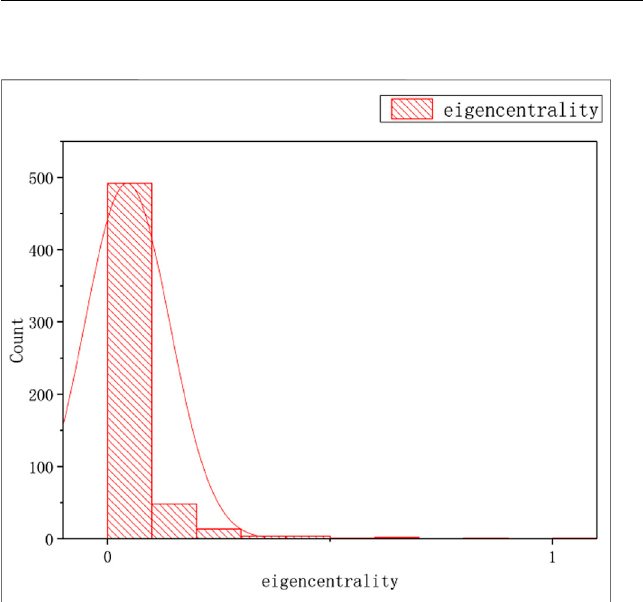
FIGURE 8 | The distribution of betweeness centrality of the TOA Network: Plot the betweeness centrality on the vertical Y -axis against betweeness centrality on the horizontal x -axis.